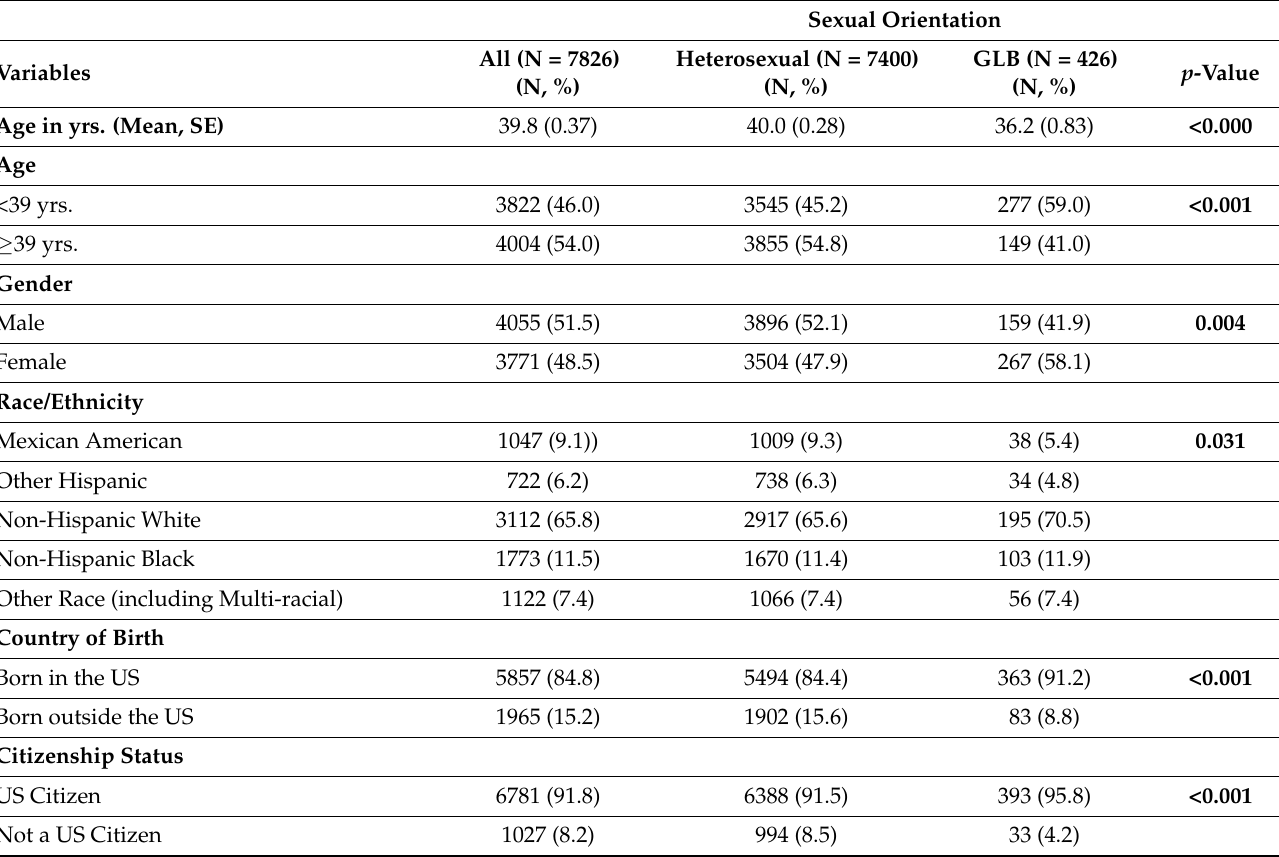
Table 1. Comparison of demographic and socioeconomic characteristics among sexual minorities compared to heterosexuals (NHANES 2011–2016). Sexual